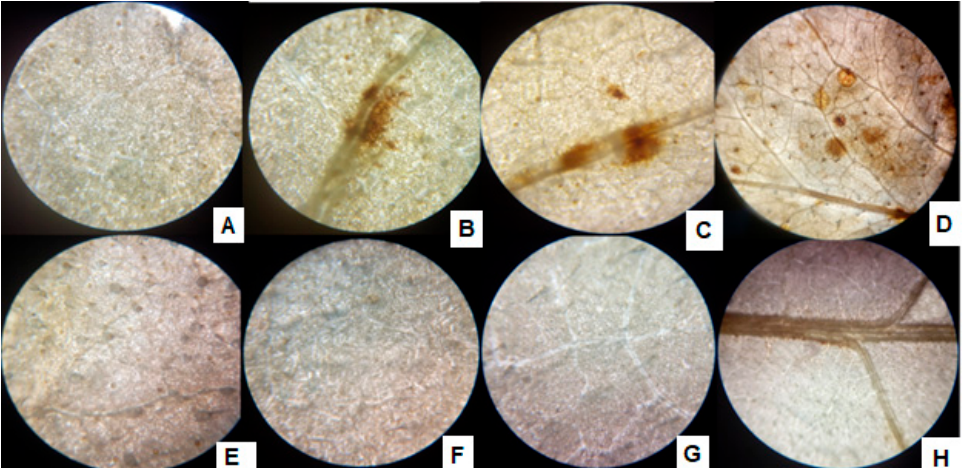
Figure 6. ROS accumulation in leaves of P1 inoculated sunflower seedlings exposed to different levels of hexavalent chromium ( A ) control (0 µg mL − 1 ), ( B ) 25 µg mL − 1 , ( C ) 50 µg mL − 1 , ( D ) 100 µg mL − 1 , and ( E ) P1 strain + 0 µg mL − 1 , ( F ) P1 + 25 µg mL − 1 , ( G ) P1 + 50 µg mL − 1 , and ( H ) P1 + 100 µg mL − 1 . The seedlings were grown hydroponically (in half-strength Hoagland’s solution) for 16 days in a plant growth chamber. Fully expanded leaves were detached and stained with DAB to visualize